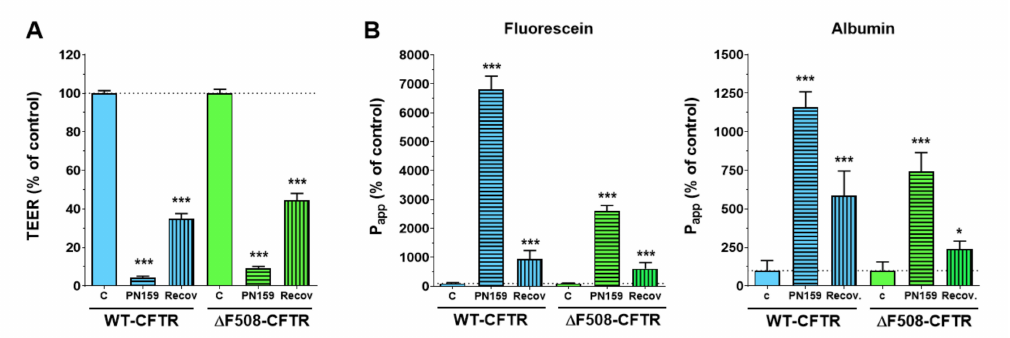
Figure 6. TEER ( A ) and permeability ( B ) values of the CFBE cell layers after a 30-min PN159 peptide treatment and a 24-h recovery period. Values are presented as a percentage of the control groups. Means ± SD, n = 4 / group. Statistical analysis: 2-way ANOVA and Bonferroni test. * p < 0.05, *** p < 0.001 compared to the control